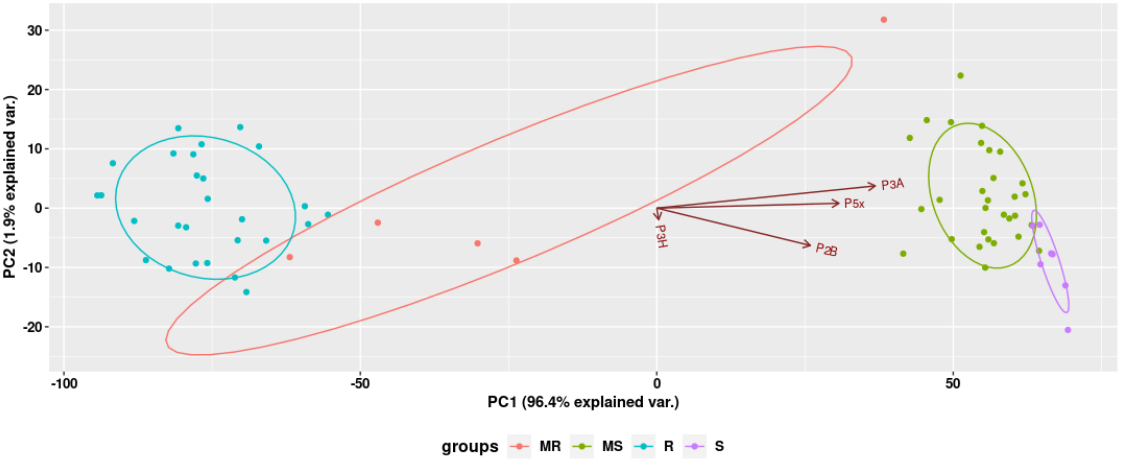
Figure 2. Principal component analysis (PCA) of the BC 1 F 8 B. napus population ( n = 68) derived from the ( B. napus × B. rapa ) × B. napus interspecific cross for resistance to Plasmodiophora brassicae pathotypes 2B (P2B), 3A (P3A), 3H (P3H), and 5x (P5x). This analysis placed the population into four groups based on disease severity index (DSI%) for these pathotypes.